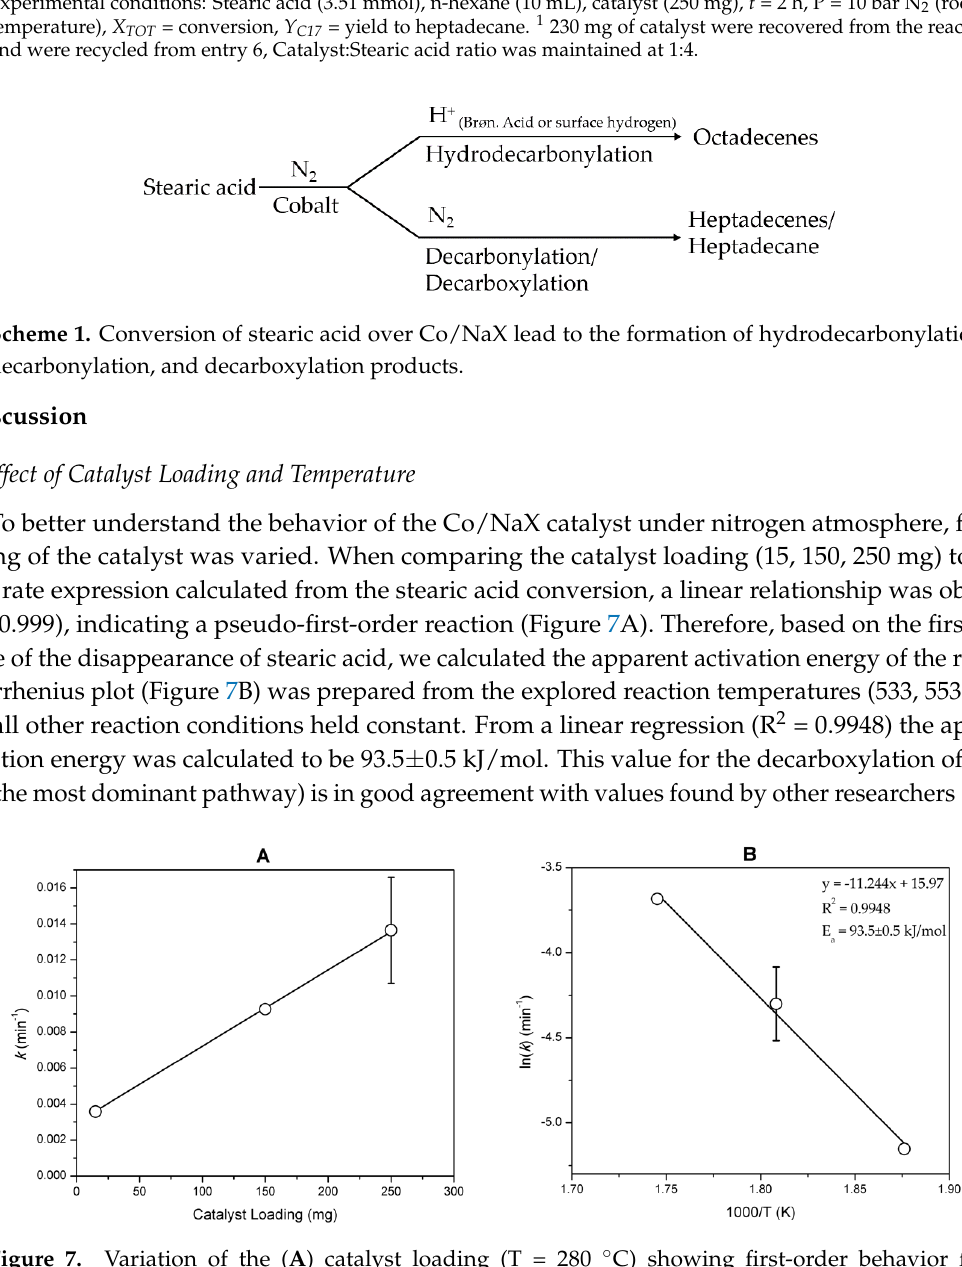
Table 2. Product distribution for the deoxygenation of stearic acid over Co/NaX catalyst in N 2 .